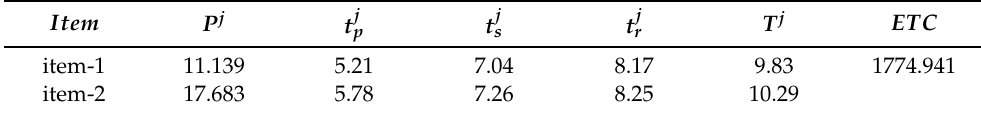
Table 4. Optimal results for the production rates P j in the numerical example.